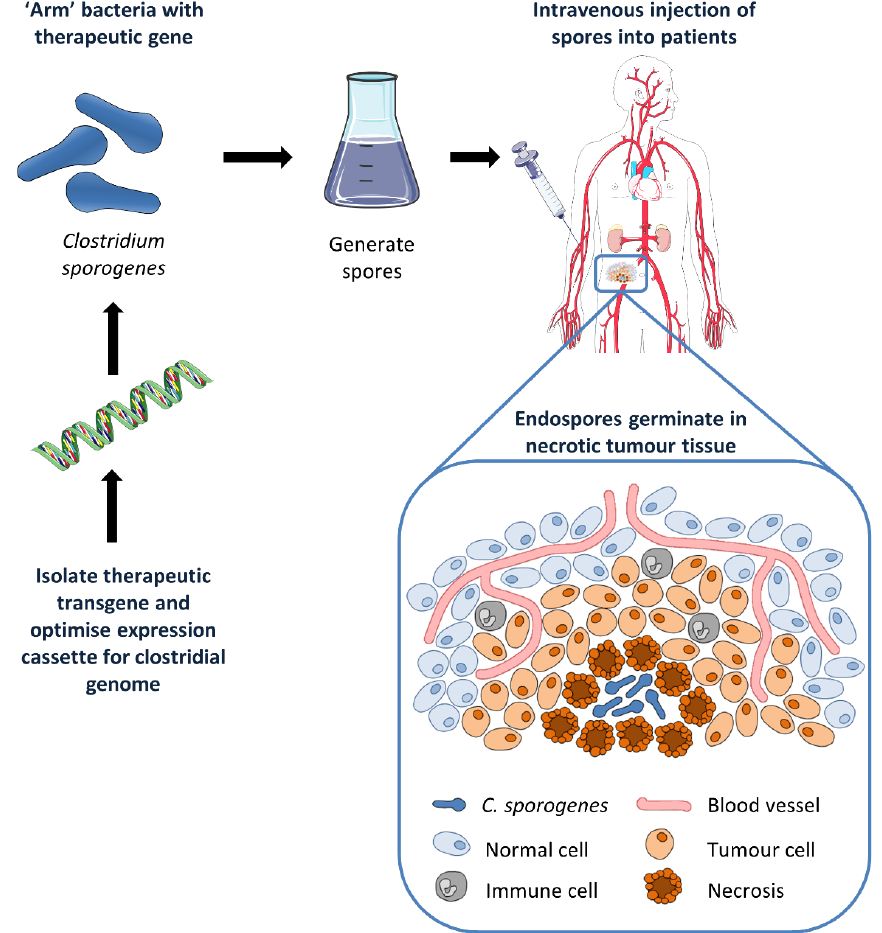
Figure 1. Cancer patients receive “armed” C. sporogenes spores which are able to germinate and colonise necrotic regions of their tumour.